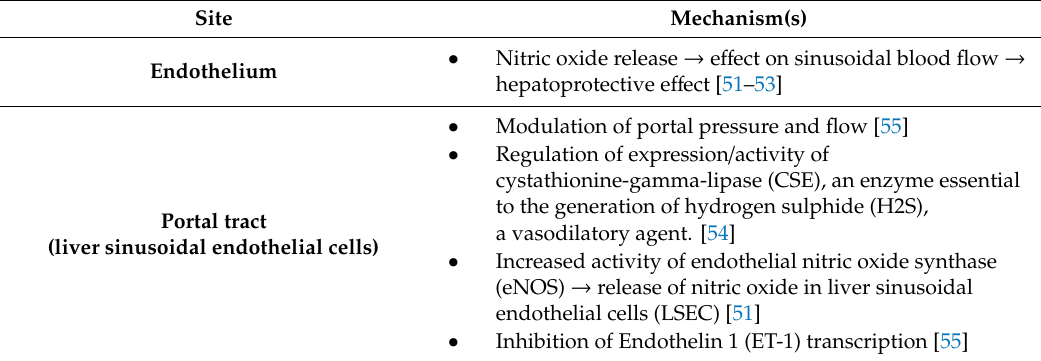
Table 3. Additional e ff ects of G protein-coupled bile acid receptor 1 (GPBAR-1) on endothelium and portal